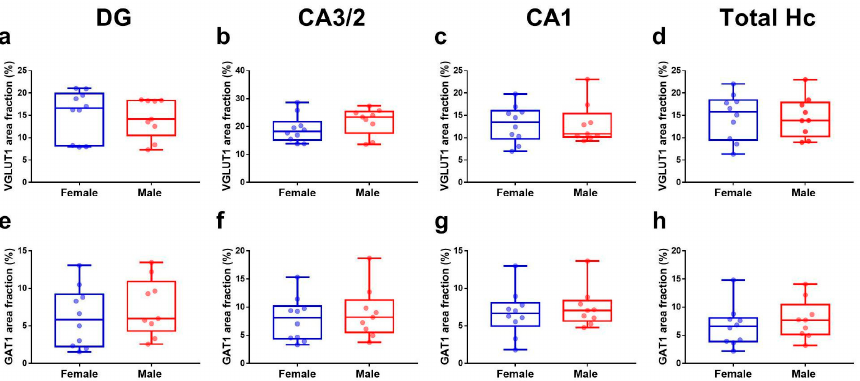
Figure 4. VGLUT1 ( a – d ) and GAT1 ( e – h ) area fractions in the hippocampus from non-demented donors grouped by sex. Donors were divided by female (blue), male (red), and year-old groups. Student t -tests between these groups were performed in the DG, CA3/2, CA1, and total hip- pocampus (Hc). Data are presented as boxplots with lines at the mean. p -values < 0.05 were